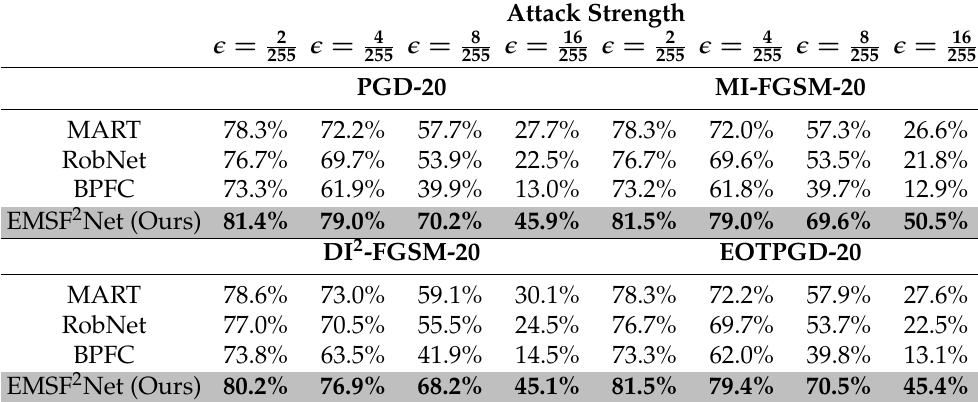
Table 4. Robust accuracy against L ∞ -norm attacks with more complexity on the CIFAR-10 dataset. The lightgray row represents the results of the proposed method, and the bold results represent the best results.